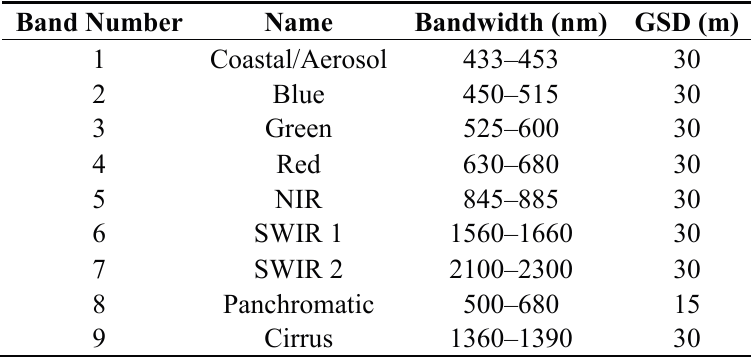
Table 1. Description of the required OLI spectral